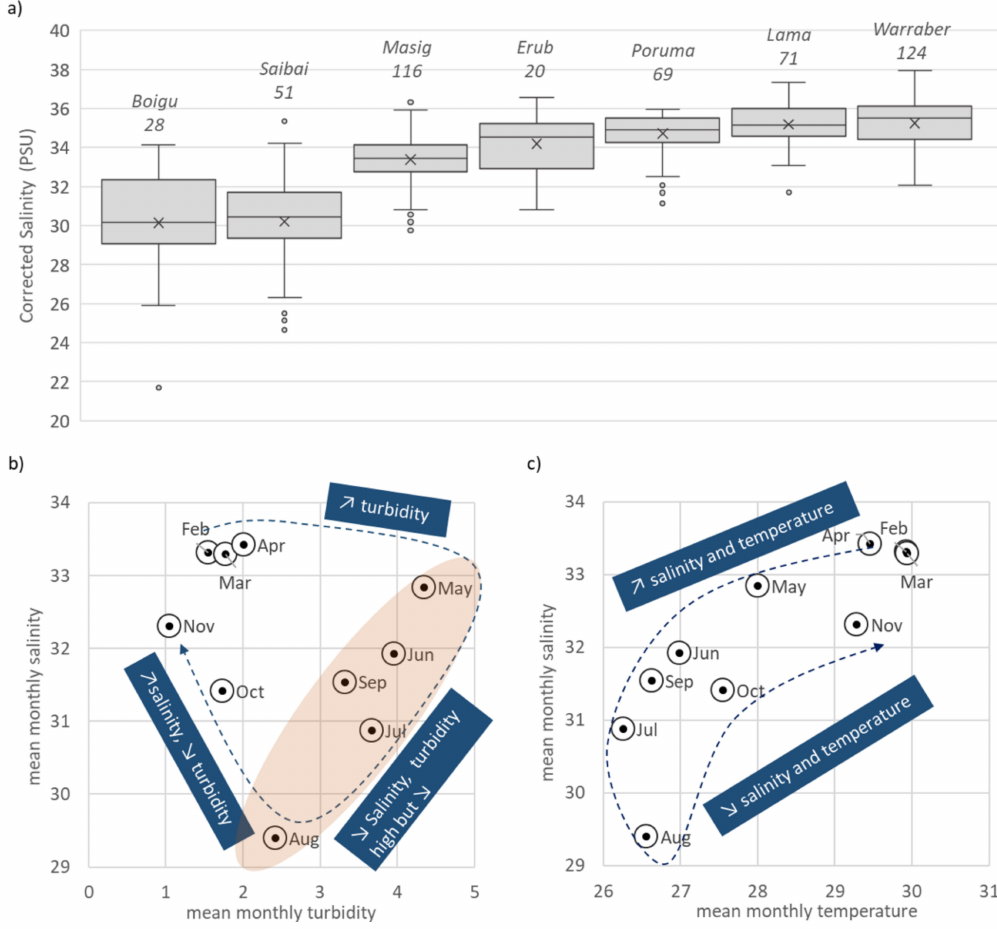
Figure 8. ( a ) Boxplots of the salinity measured at Boigu, Saibai, Masig, Erub, Poruma, Iama and Warraber Islands. Amount of data collected at each site is indicated (italic font). Bottom: Plots of the mean monthly logger data collected at the northern end of Warrior Reef in 2020 for ( b ) salinity-turbidity and ( c ) salinity-temperature ([22], modified). The red area highlights months with increased turbidity and decreased salinity levels that may indicate the influence of diluted riverine plume